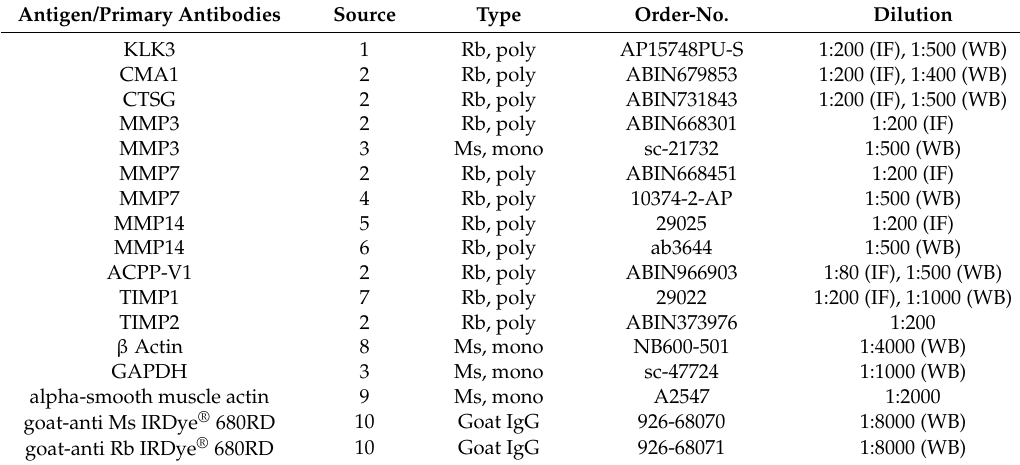
Table 5. Antibodies used in indirect immunofluorescence (IF) and Western blotting (WB).